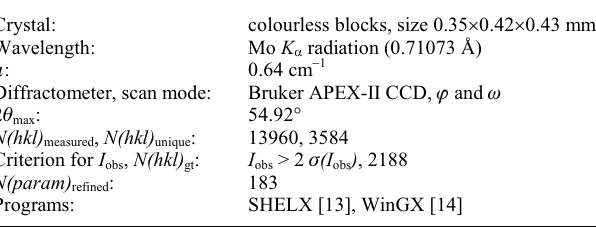
Table 1. Data collection and